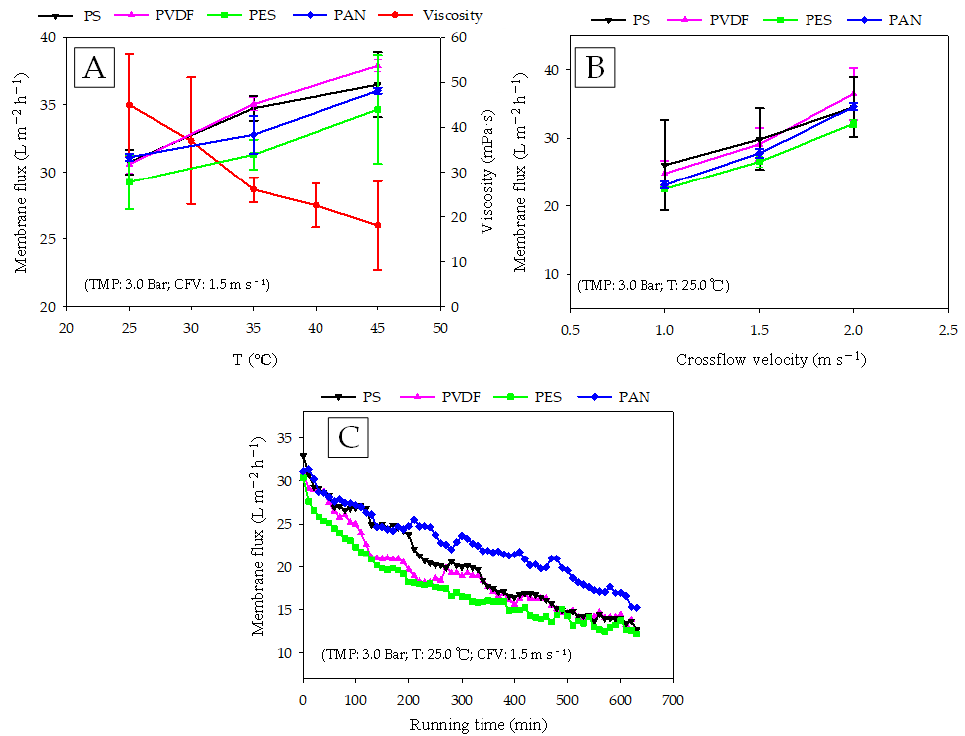
Figure 2. Effects of ( A ) temperature; ( B ) cross flow velocity (CFV) ( C ) running time, on the membrane fluxes using different polymeric ultrafiltration membranes.